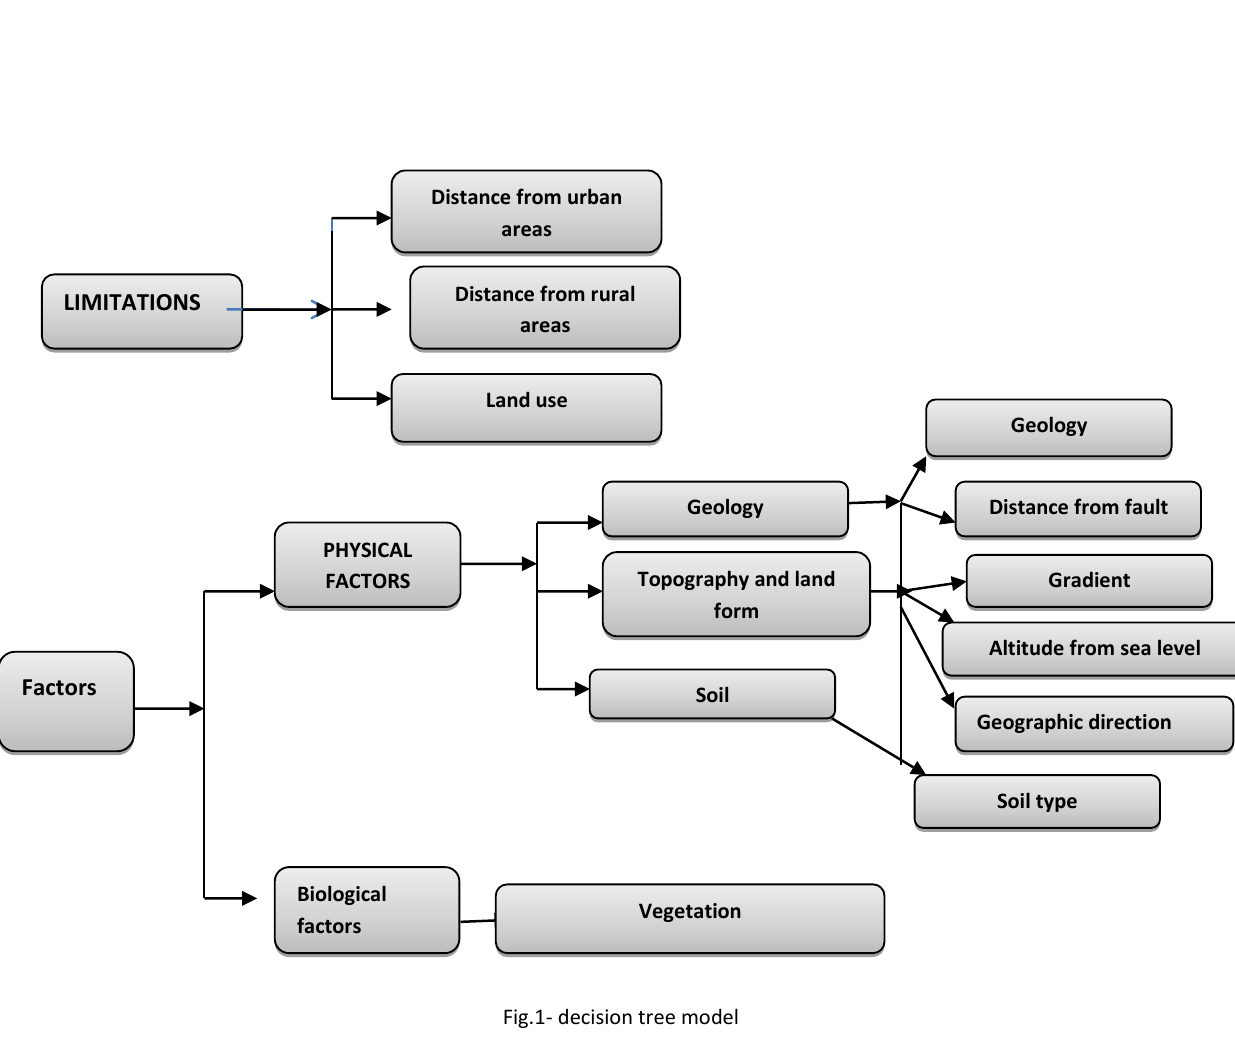
Fig.1- decision tree